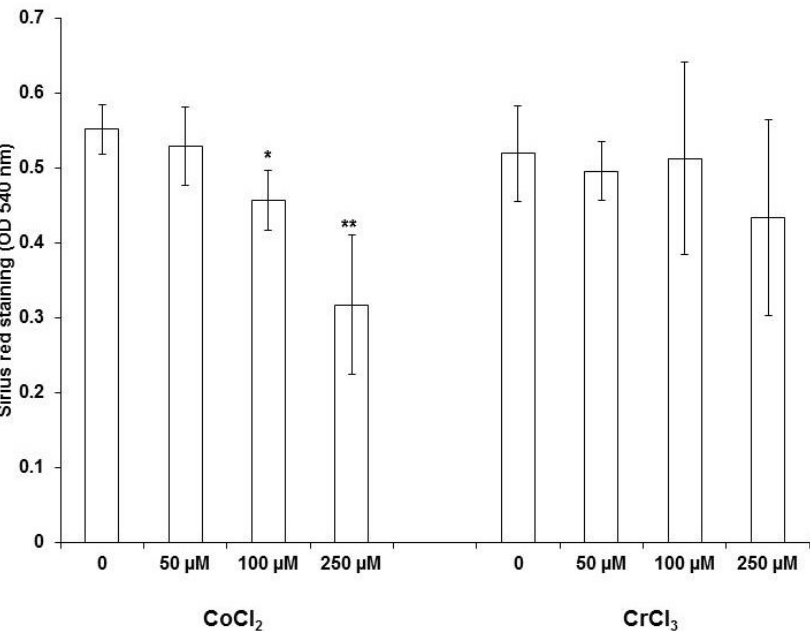
Figure 5. Influence of Co 2+ and Cr 3+ on collagen secretion by MG63 cells determined using Sirius red staining, one-way ANOVA p < 0.001 for CoCl 2 treatment. For pairwise comparison a post hoc Bonferroni test was applied (* p < 0.05, ** p < 0.01 vs. unstimulated control). Data represent results of four independent experiments, each performed in triplicate.